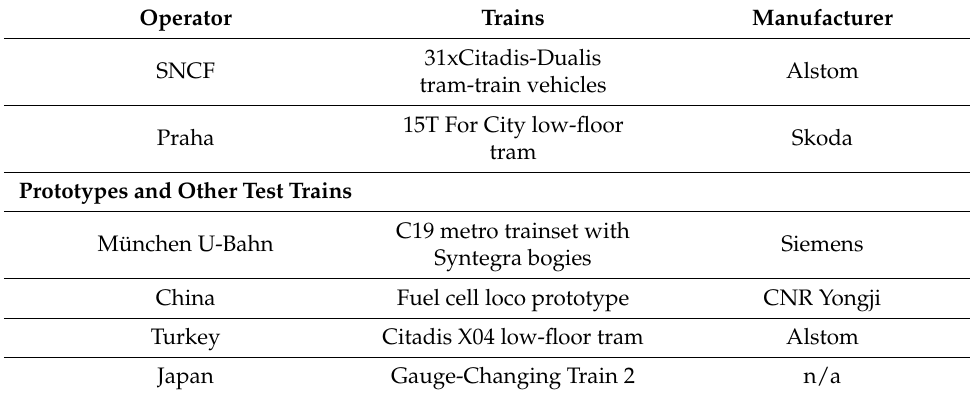
Table 1. Selected light railways using permanent magnet motors